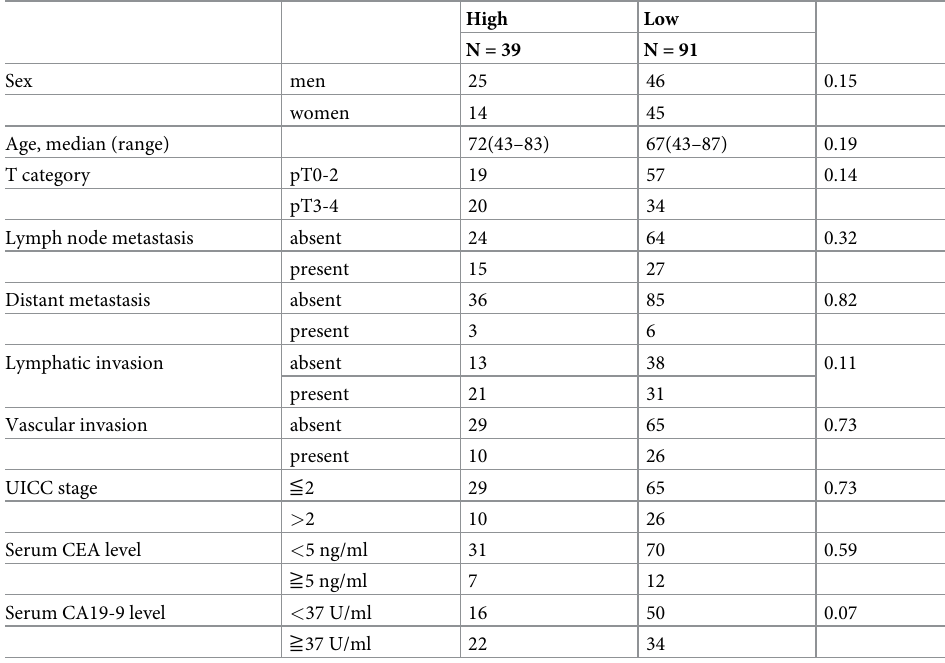
Table 3. Correlation between clinicopathological features and TAMs in 130 patients with